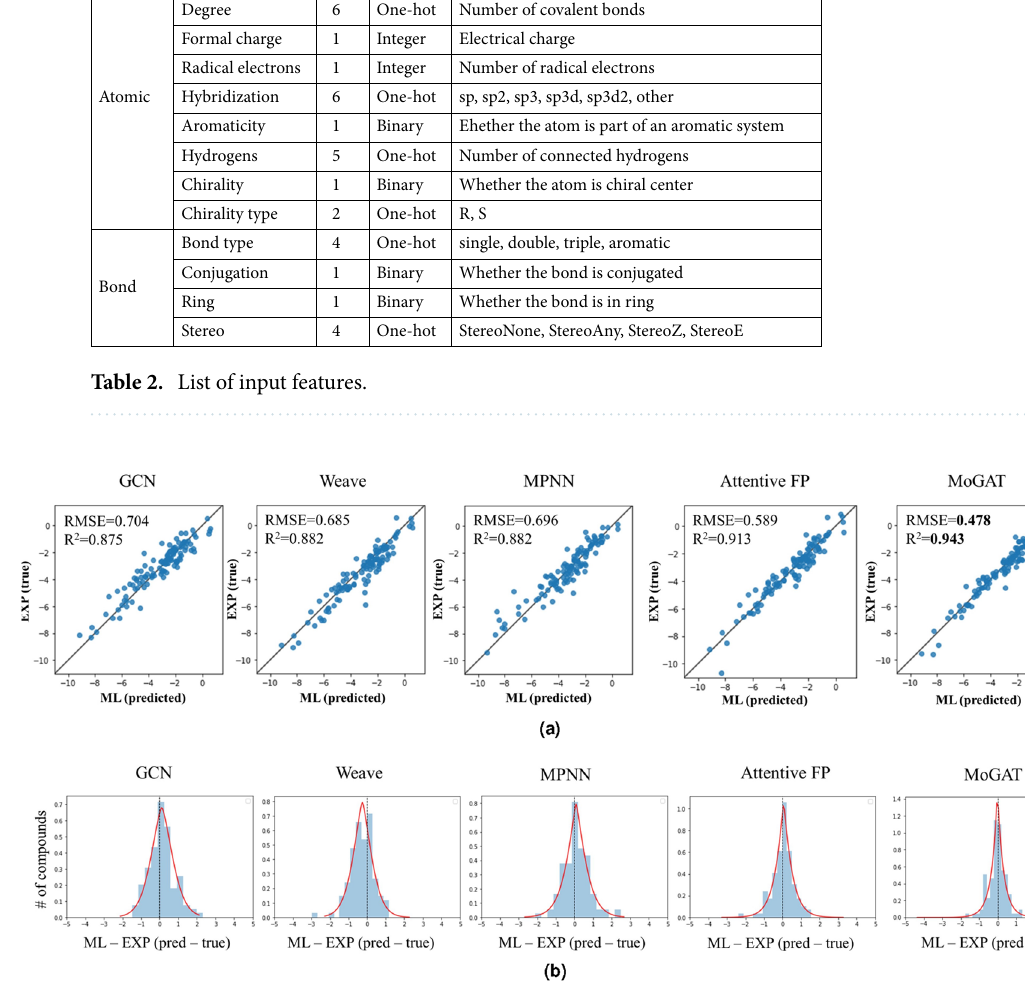
Figure 2. Comparison of the proposed method and other baseline models in estimating water solubility. ( a ) Scatter plots of predicted and experimental solubility values, where the x-axis and y-axis indicate the predicted and experimental solubility values. ML and EXP indicate the predicted and experimental solubility values, respecitvely. ( b ) Generalized error distribution of the errors between ML and EXP. The unit of water solubility is logS.